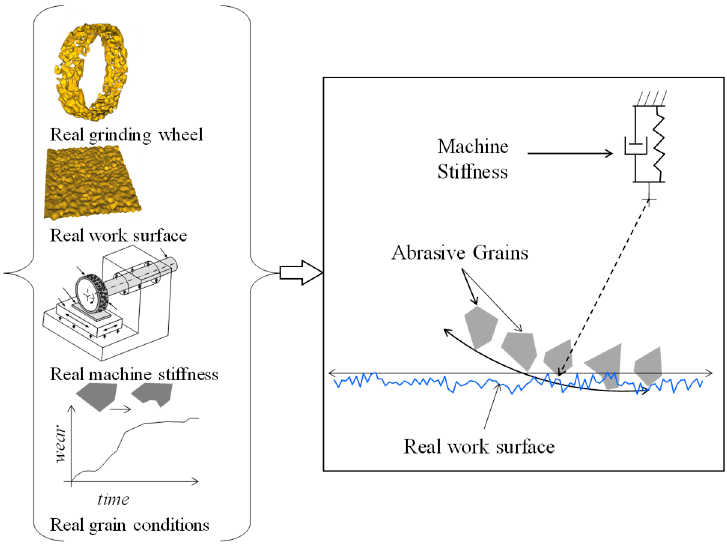
Figure 1. Reality in grinding and microscopic interaction between grinding wheel and workpiece surface.